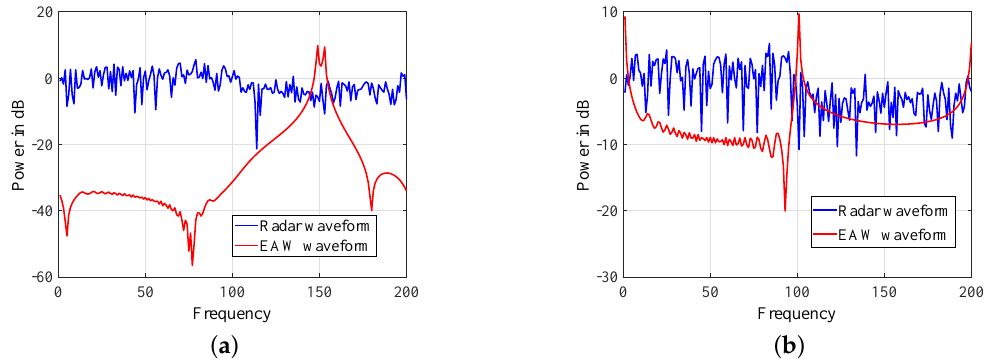
Figure 6. Spectrum of eigenvectors-as-waveforms (EAW). ( a ) Eigenvector corresponding to smaller eigenvalue. ( b ) Eigenvector corresponding to larger eigenvalue.